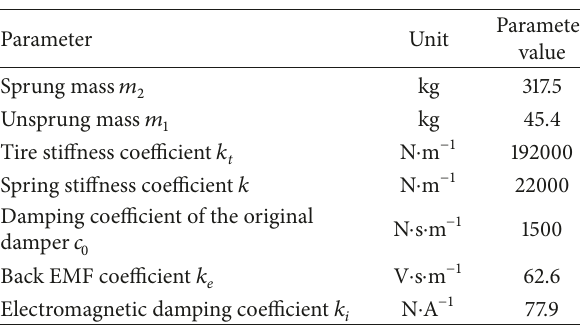
Table 1: Simulation parameters.